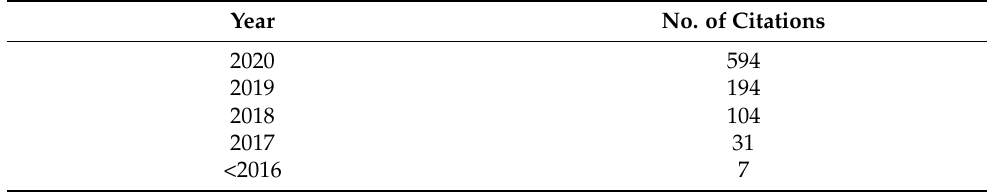
Table 6. An analysis based on publication citations for IoT in